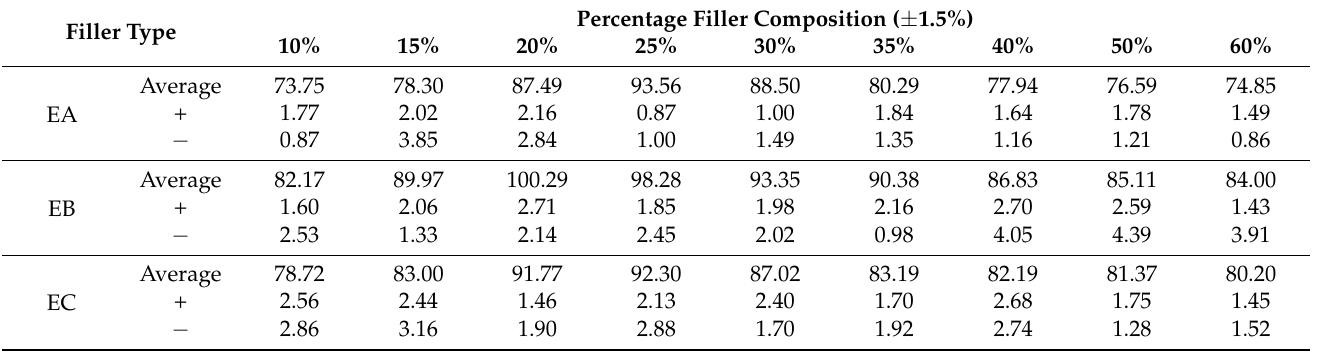
Table 8. Summary of Compressive strength values for EA, EB, and EC.